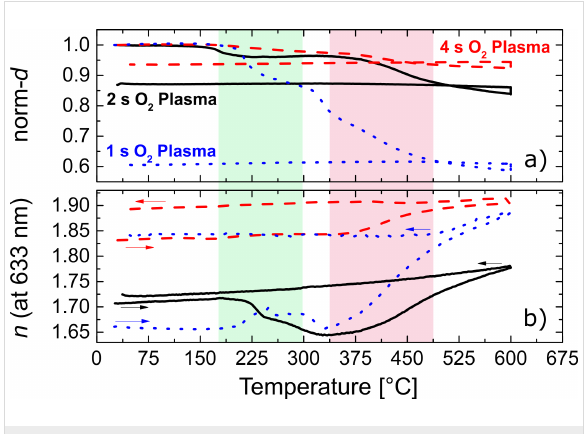
Figure 3: a) Normalized thickness (norm- d ) and b) refractive index n (at 633 nm) of the zincone-like layers as a function of the annealing temperature. The two critical temperature ranges for initial removal of organic moieties and growth of ZnO crystals are highlighted. The two parameters were modeled from the SE data acquired in situ during the annealing of the thin films. The thickness is reported as normalized